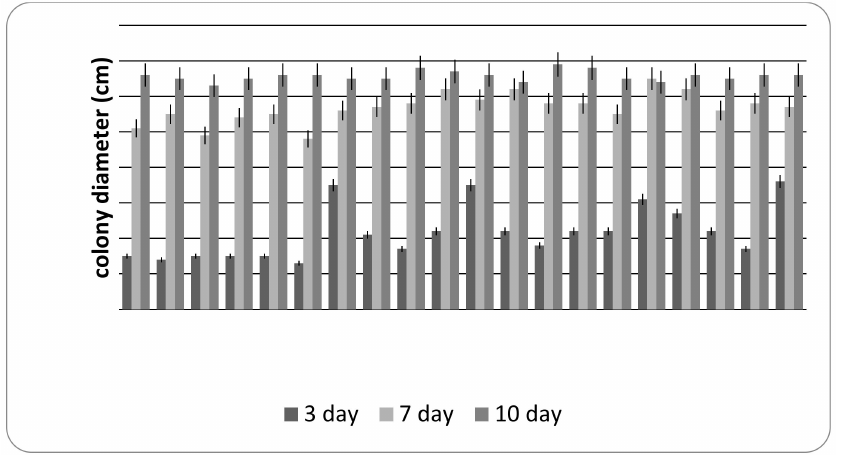
Figure 5. Dynamics of the pathogen Phomopsis juglandina on malt agar (x-axis shows the repetition